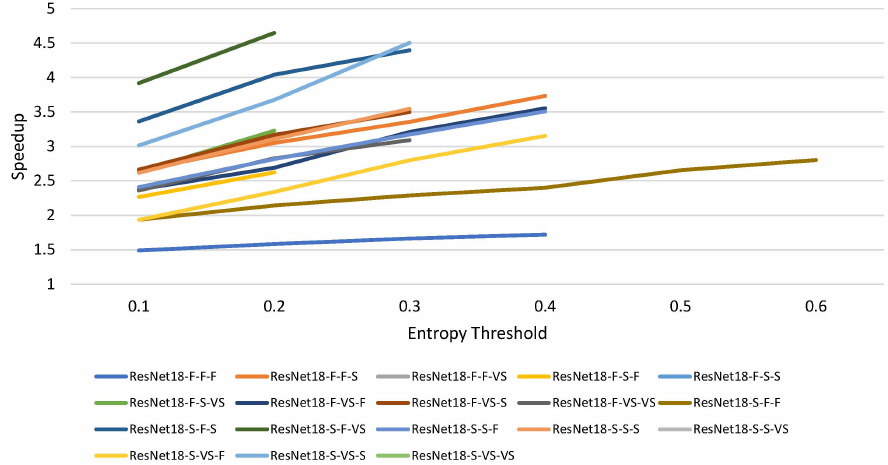
Figure 6. Speedup of the dual model for different combinations of a small model with ResNet50.